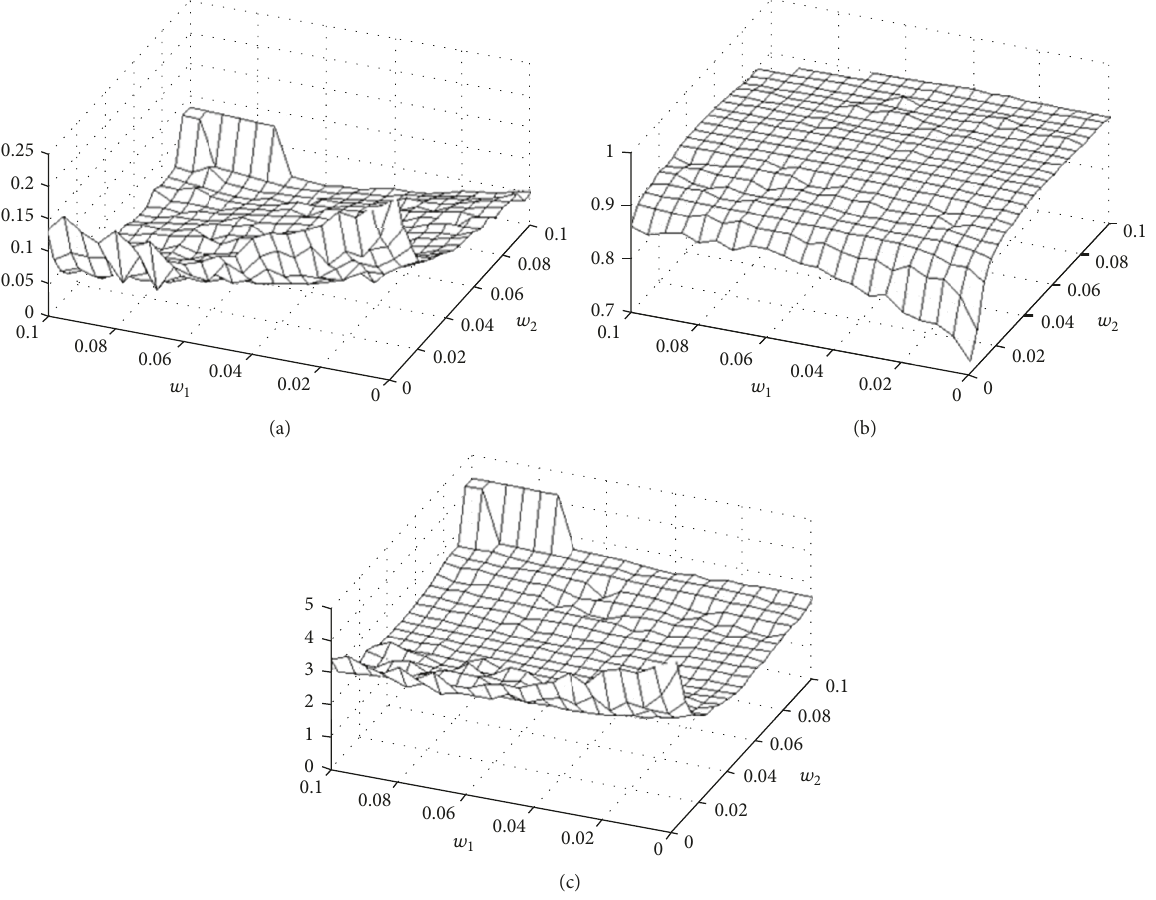
Figure 3: MRI-cryo-quantitative registration quality in lungs. From (a)–(c), plots are volume difference, Dice, and surface distance. We performed 421 registration experiments by varying weights 𝑤 1 and 𝑤 2 associated with bending energy and Jacobian determinant regularization terms, respectively. Lungs were interactively segmented in cryo- and MRI volumes to enable quantitative assessments for registration